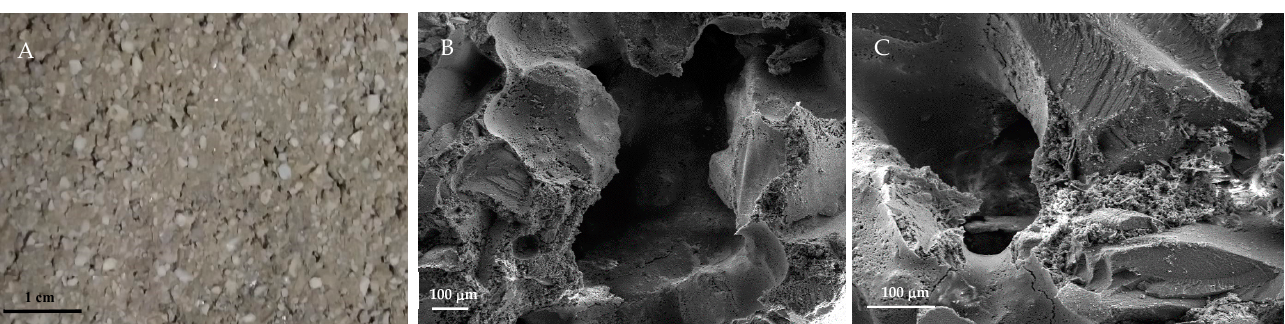
Figure 8. ( A ) Image of the PET1 (800 g of PET) sample surface, ( B , C ) SEM detections of the PET1 sample.